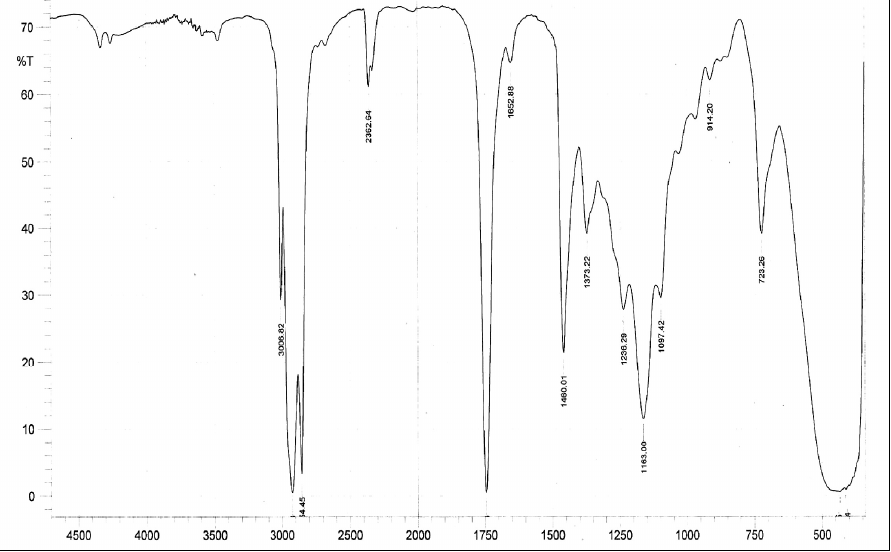
Figure 1. IR spectrum of olive